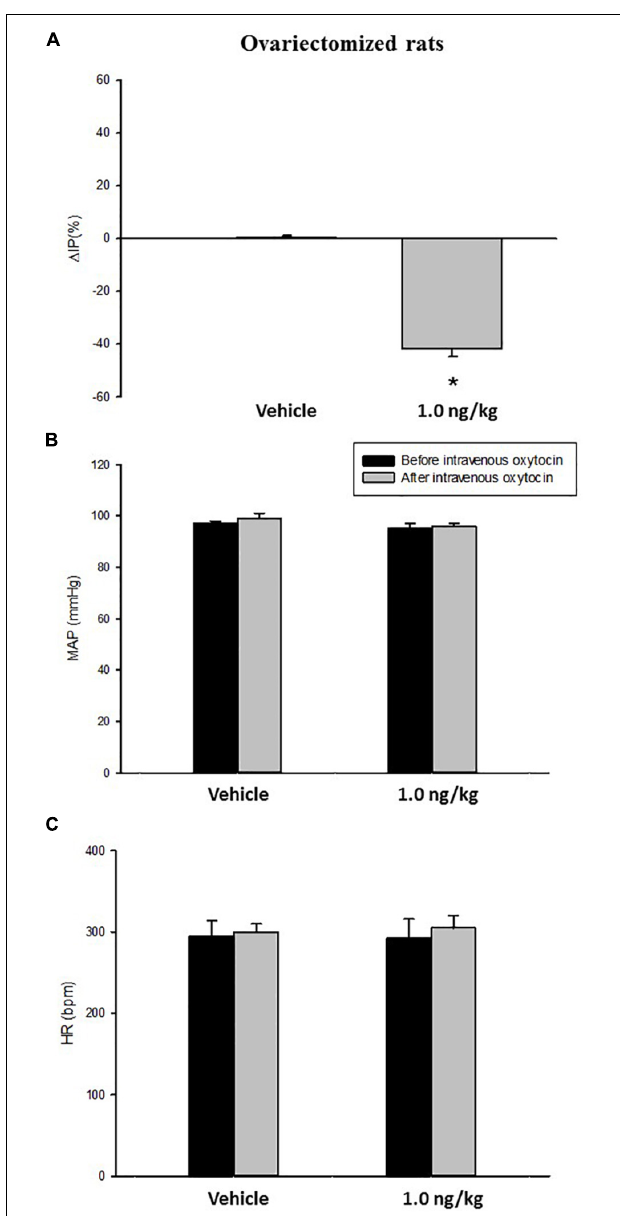
FIGURE 2 | Percent change in intravesical pressure ( A , % (cid:49) IP) after intravenous injection of saline (vehicle) or oxytocin dose (1.0 ng/kg of b.w.). Mean arterial pressure ( B , MAP, mmHg) and heart rate ( C , HR, bpm) at baseline and after intravenous injection of saline (vehicle) or oxytocin dose (1.0 ng/kg of b.w.) in ovariectomized animals * p < 0.05 vs. saline ( N =